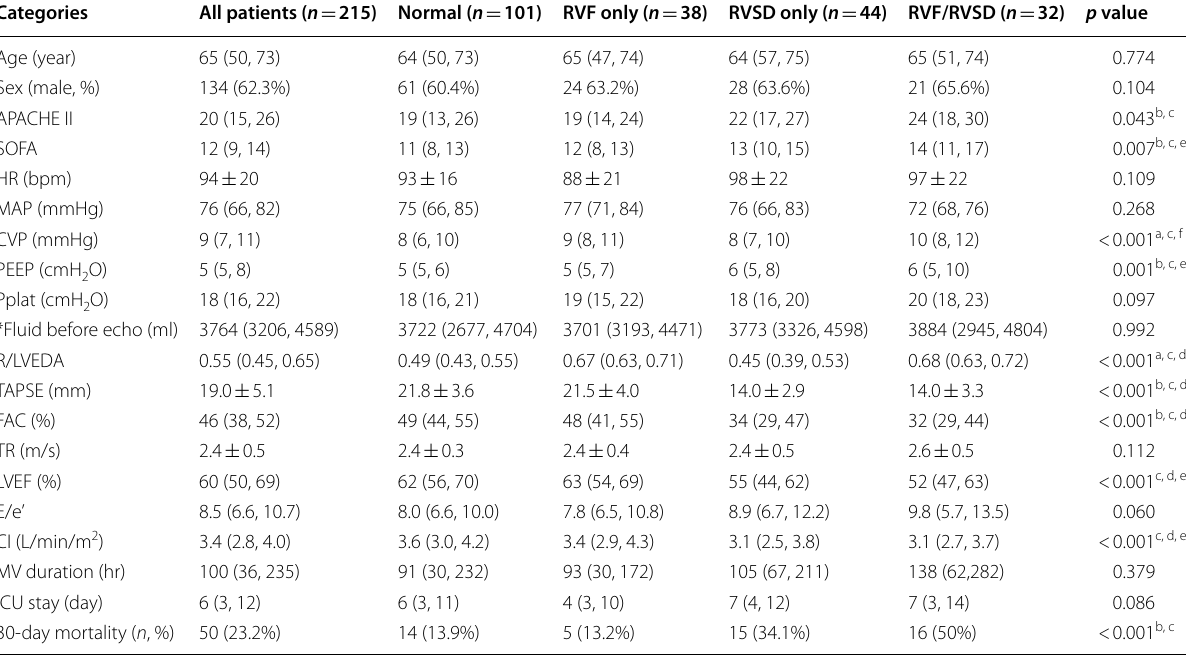
*Fluid administered within 24 h before echo examination a RVF/RVSD vs. RVSD, p < 0.05; b RVF/RVSD vs. RVF, p < 0.05; c RVF/RVSD vs. Normal, p < 0.05; d RVSD vs. RVF, p < 0.05; e RVSD vs. Normal, p < 0.05; f RVF vs. Normal, p < 0.05 excursion, FAC fractional area change, TR tricuspid regurgitation, LVEF left ventricular ejection fraction, CI cardiac index, MV mechanical ventilation, ICU intensive care unit